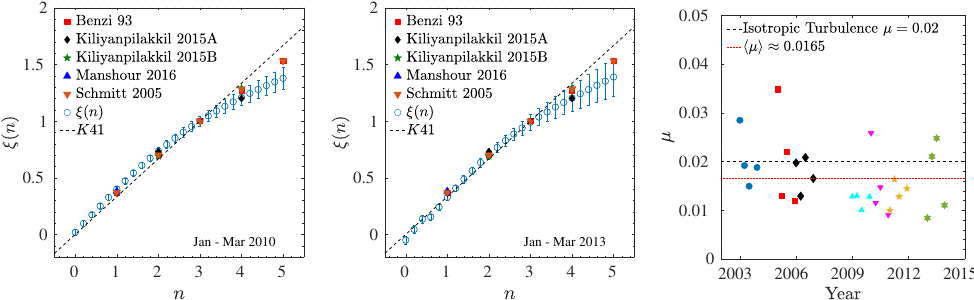
Figure 10. Left panel : comparison of the scaling exponents obtained from MLO wind data (January–March 2010) ( open circles ) with other exponents taken from the literature for various systems: hydrodynamic turbulence using extended self-similarity (ESS) (squares) [38], atmospheric boundary layer in the mesoscale regime ( diamonds and stars ) [10,23], and other estimates in hydrodynamic turbulence [35,89]; the dashed line represents the theoretical expectation n /3, as estimated from dimensional analysis in the absence of intermittency [48]. Central panel : as the previous case for the sample January–March 2013. Right panel : intermittency parameter estimated via the log-normal model (Equation (12)) for the MLO wind speed data; each point represents a 90-day sample. The horizontal dashed line represents the value µ ≈ 0.02 obtained for isotropic turbulence in the inertial sub-range, the dotted line represents the average intermittency value (cid:104) µ (cid:105) ≈ 0.0165 ± 0.0031 for the MLO wind speed data. The value of (cid:104) µ (cid:105) is in good agreement with other estimates [90] obtained with different